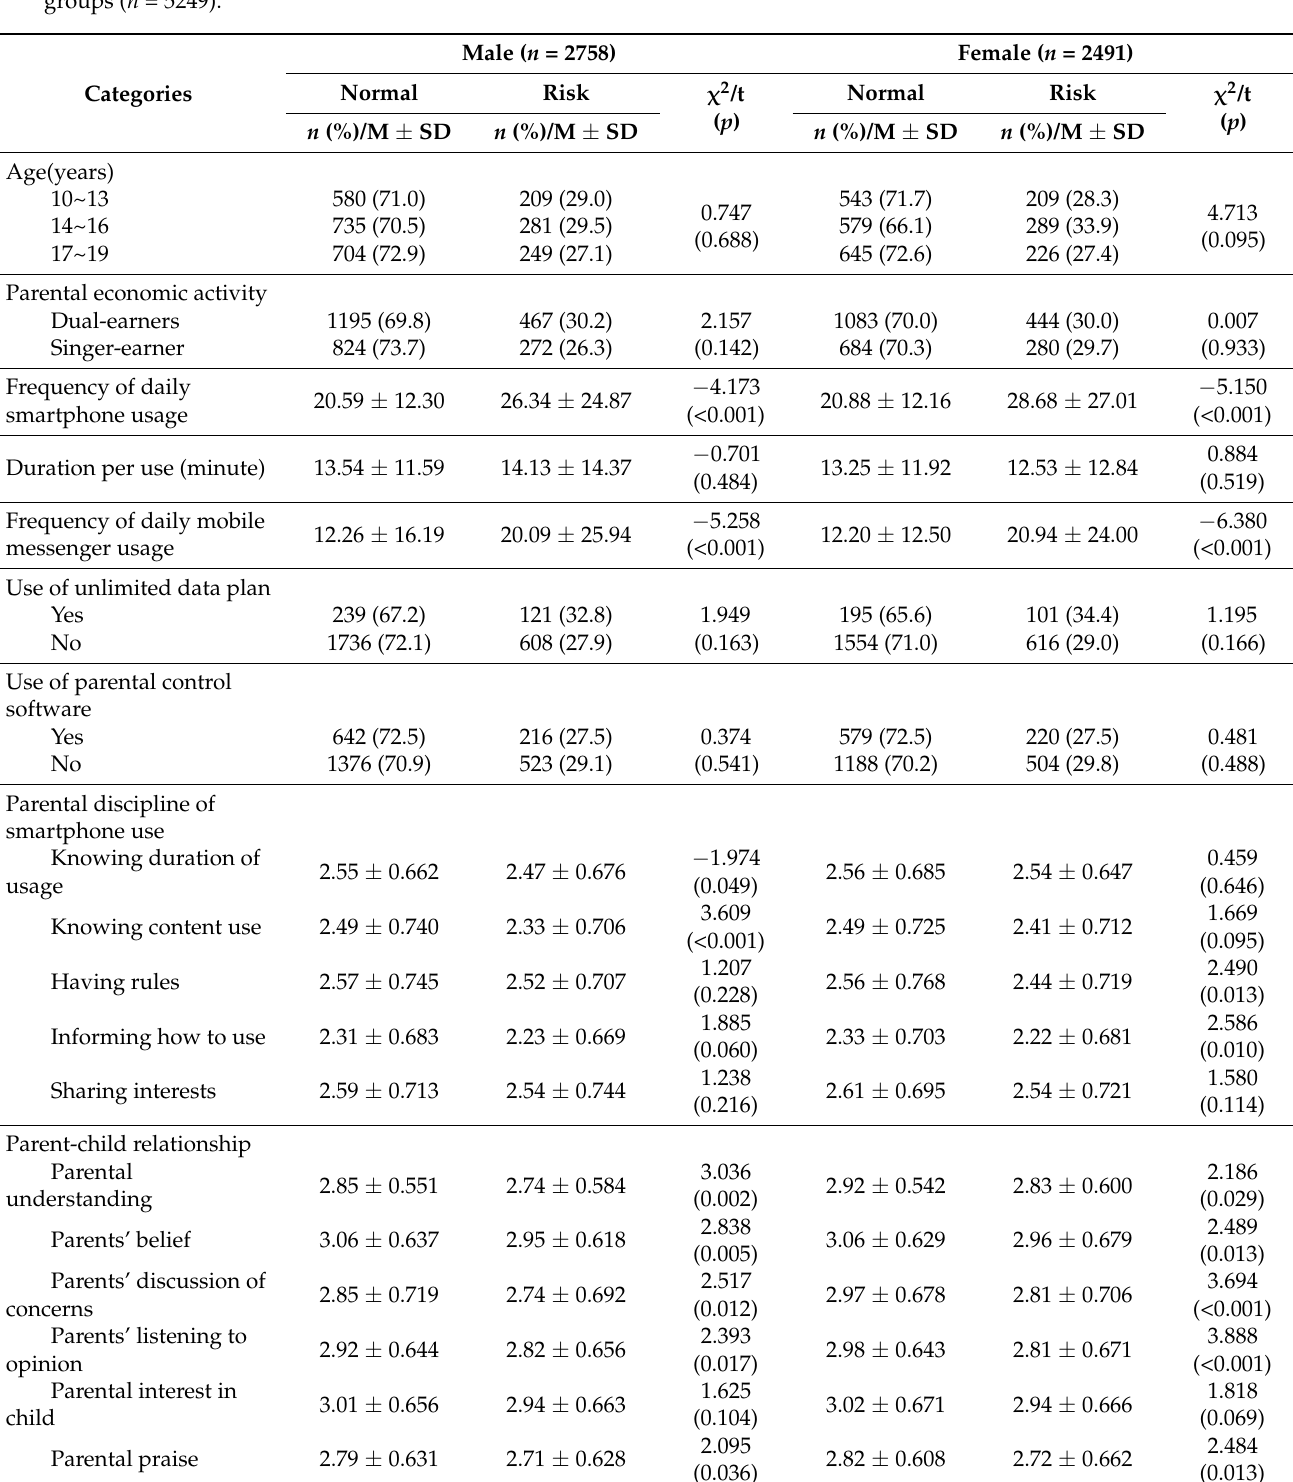
Table 2. Differences in demographics, characteristics of smartphone usage, and factors related to parents between the two groups ( n =